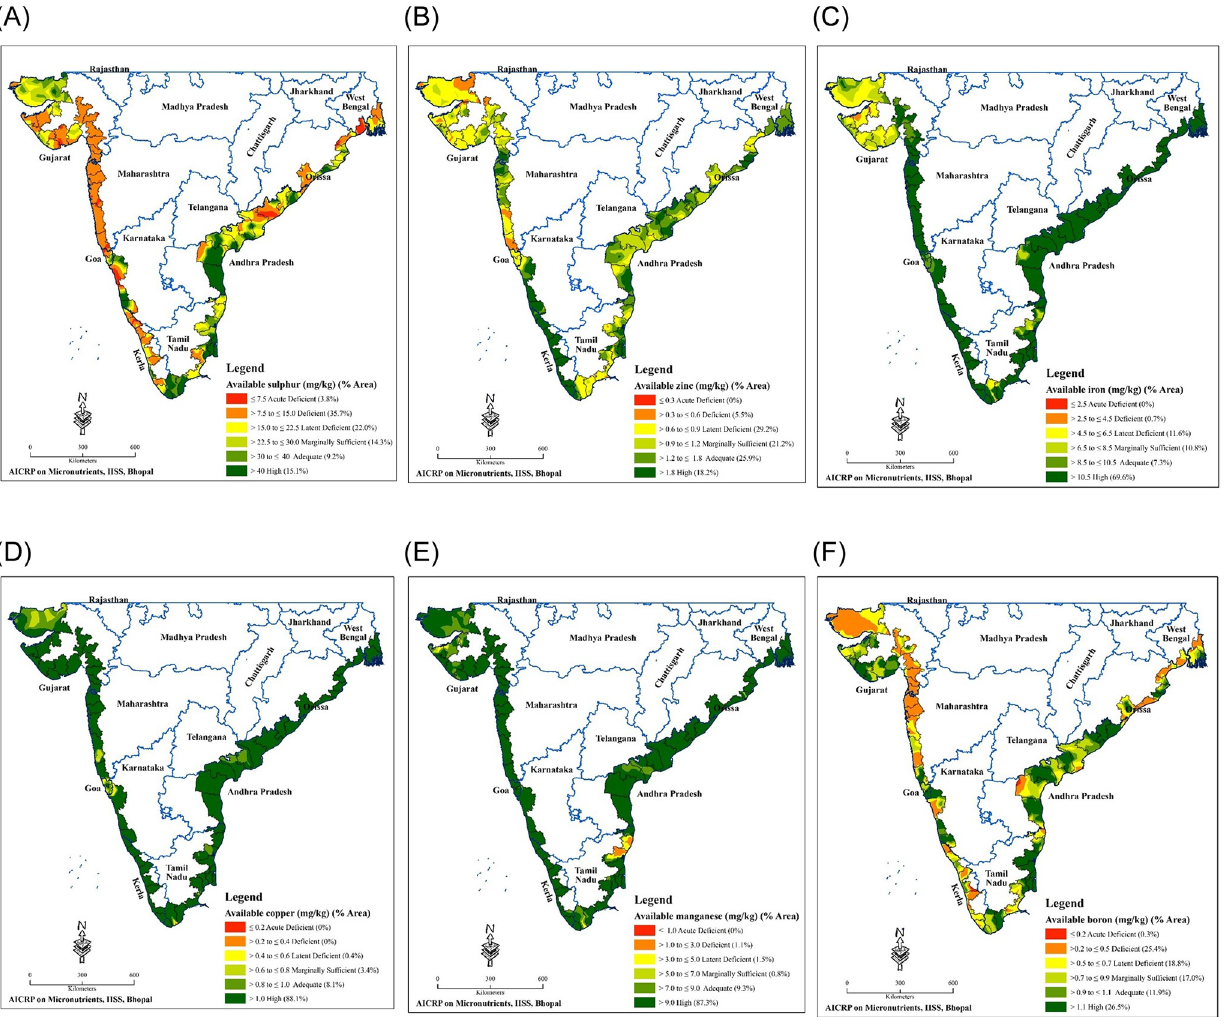
Fig 3. Distribution maps of available nutrients in study